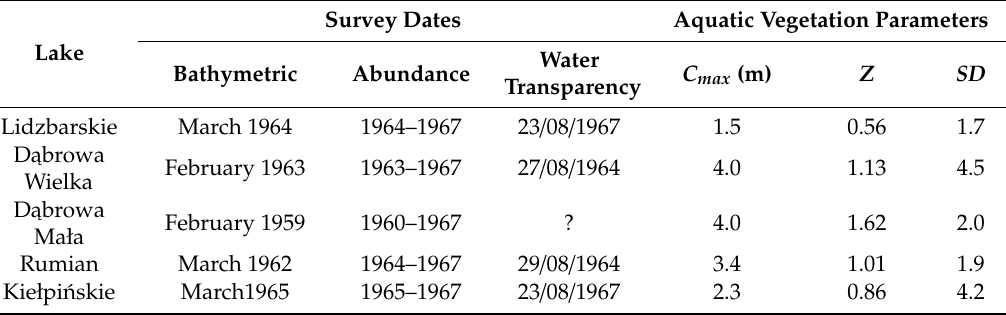
Survey dates and read from bathymetric plans the aquatic vegetation parameters ( Z —colonization index, C max —maximum vegetation depth; SD —Secchi disc) in five lakes in the Wel Landscape Park in the